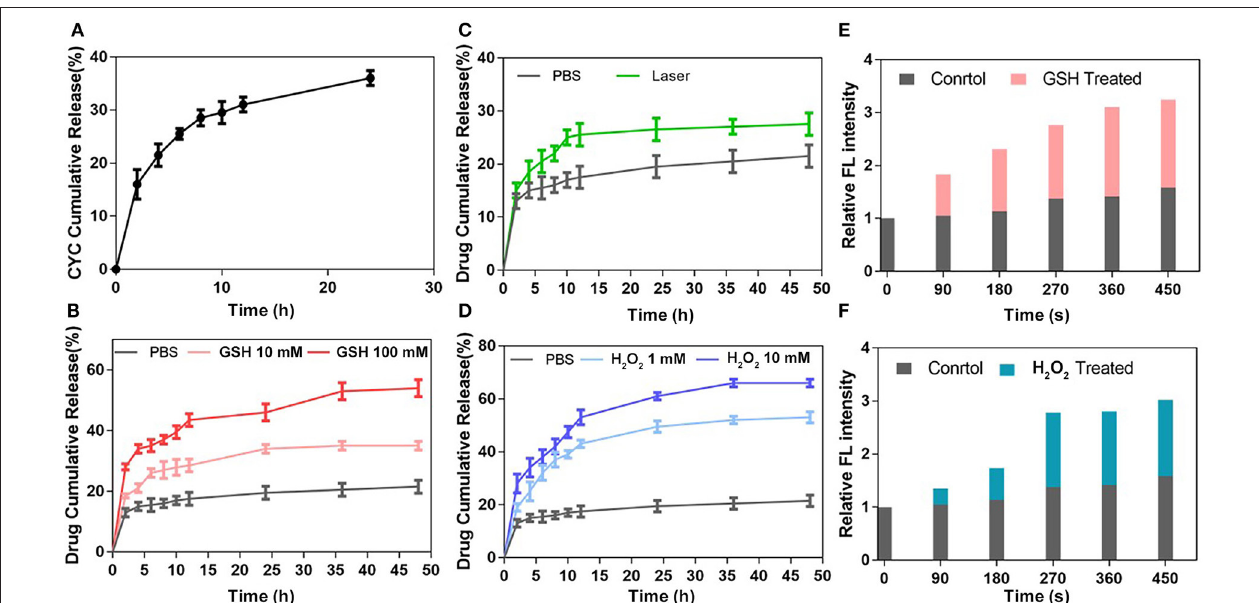
FIGURE 2 | Drug release behavior of ABN@HA-sese-Ce6/CYC NPs. (A) The Ce6 release of ABN@HA-sese-Ce6/CYC NPs in PBS, 10mM GSH, 100Mm GSH, respectively. (B) The Ce6 release of ABN@HA-sese-Ce6/CYC NPs in PBS, 1mM H 2 O 2 , 10mM H 2 O 2 . (C) The Ce6 release of ABN@HA-sese-Ce6/CYC NPs when treated with 650nm laser (20 mW/cm 2 ). Without the laser treatment group as a control. (D) The CYC release of ABN@HA-sese-Ce6/CYC NPs in PBS. (E) Singlet oxygen generated by the released Ce6 of ABN@HA-sese-Ce6/CYC NPs in 10mM GSH treated group when exposed to 650nm laser (20 mW/cm 2 ). PBS group as a